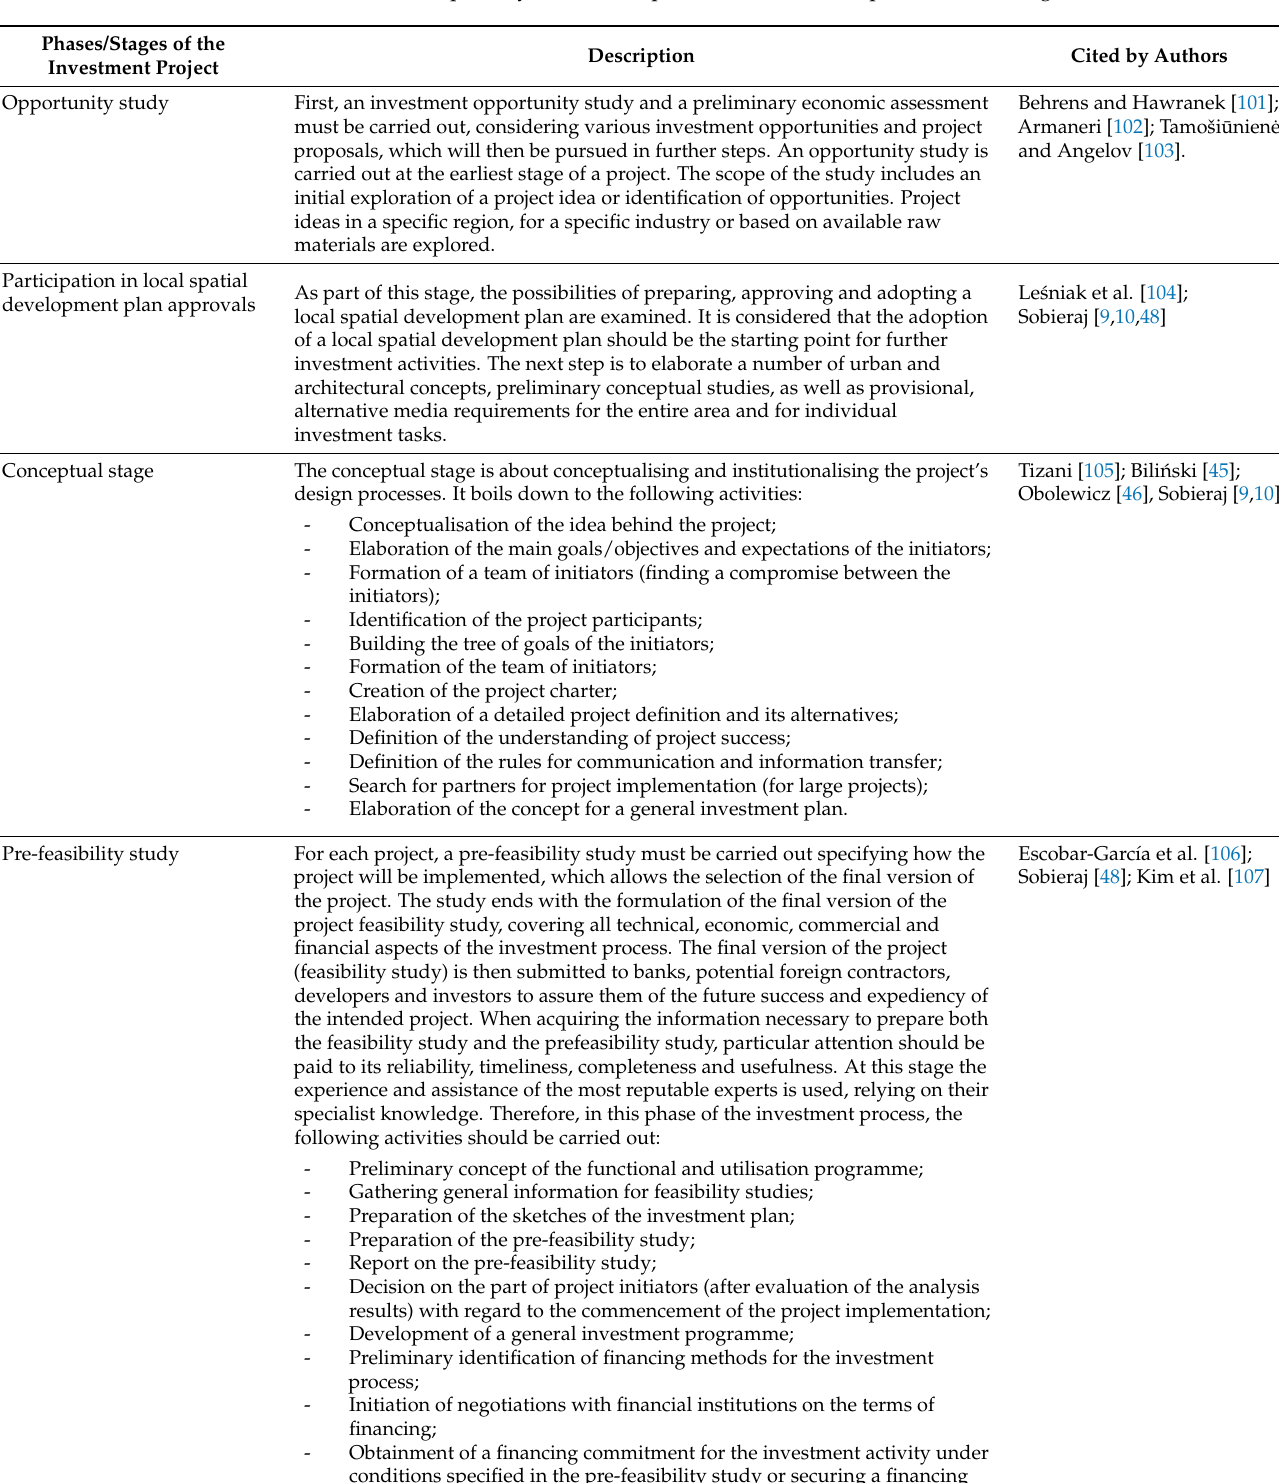
Table A1. Proprietary investment process model. Description of all its